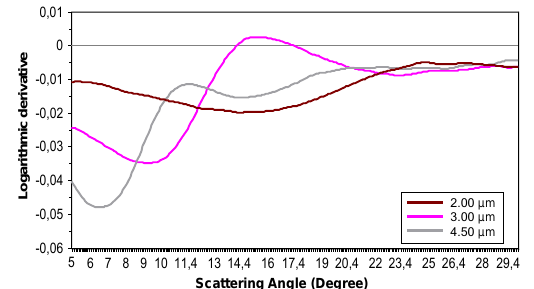
Fig. 2. Logarithmic derivative of the scattering intensity plots for different microplastic diameters.